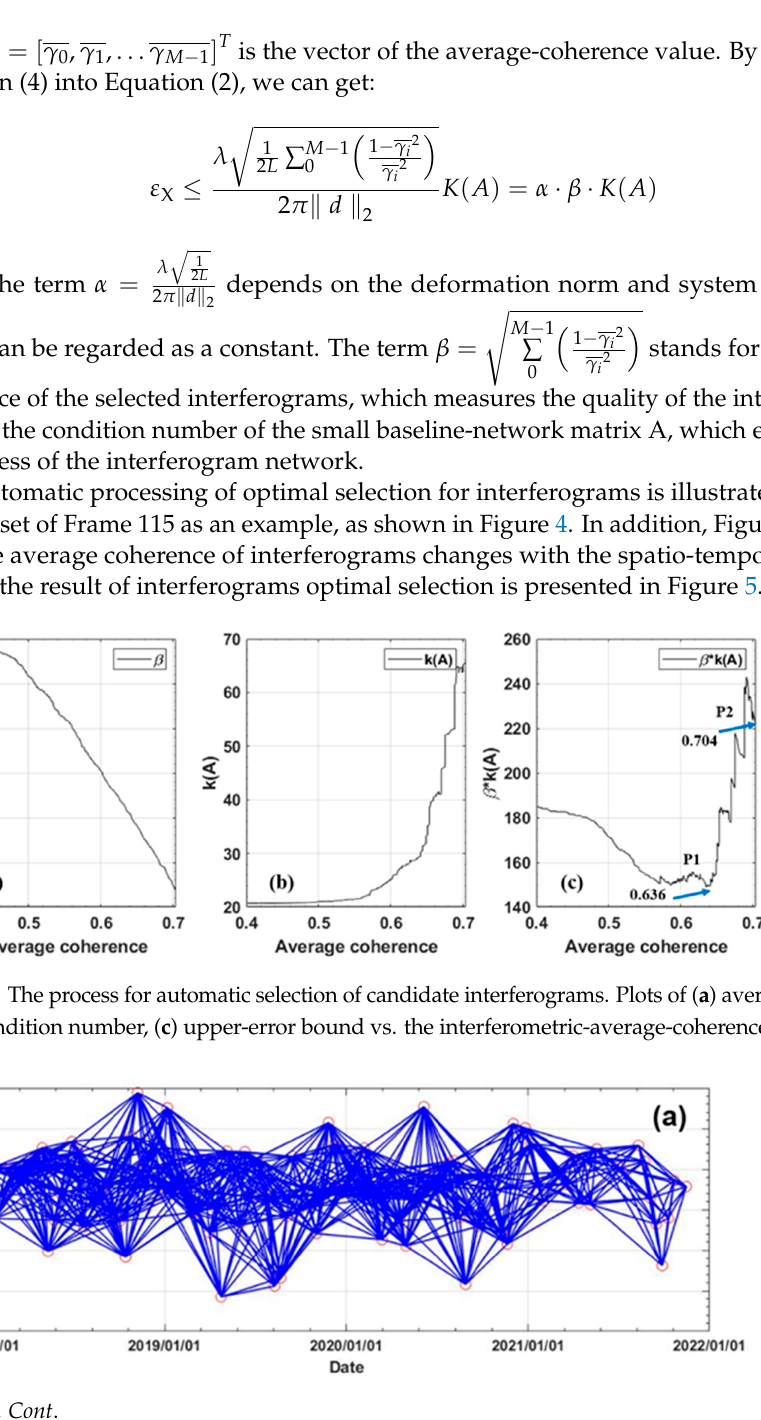
Figure 5. Distribution of interferograms in a temporal/perpendicular baseline domain. ( a ) Set of available interferograms generated by setting a maximum temporal baseline separation of 150 days and spatial baseline of ±150 meters. ( b ) Optimal network of interferograms retrieved by applying the proposed InSAR automatic selection method. ( c ) Reduced network of interferograms at bound- ary condition where one single data pair exists that connects the group of interferograms to form a single set of data. Note that ( b , c ) refer to the condition on minimum average spatial coherence of selected interferograms of 0.636 (P1 in Figure 4) and 0.704 (P2 in Figure 4). 3.2.3. Evaluation of Landslide Activity The evaluation of landslide activity mainly takes into account three statistical values: (1) activity index, which is defined as the proportion of active pixels for one landslide, i.e., the ratio between the number of active pixels (pixels with deformation rate larger than the given threshold; the absolute value of 20 mm/year) and the total number pixels for one landslide; (2) the mean deformation rate of all pixels for each landslide, which is used to preliminary identify the activeness of surface; and (3) the maximum value of all pixels for each landslide, which is used to estimate the maximum activeness of the landslide body. Due to morphological structure and the deformation distribution of different failure surfaces, instability in landslides can evolve in different ways. To assess the spatial kine- matic s of the landslide, the probability density curves were used to demonstrate the de- formation rate frequency distributions and spatial zonation, and longitudinal slope curves were used to interpret the segmented failure surface. 3.2.4. Correlation between Landslide Deformation and Rainfall CWT was used to extract features from individual time series of periodic deformation and daily precipitation, in which positions with high values in the CWT representation